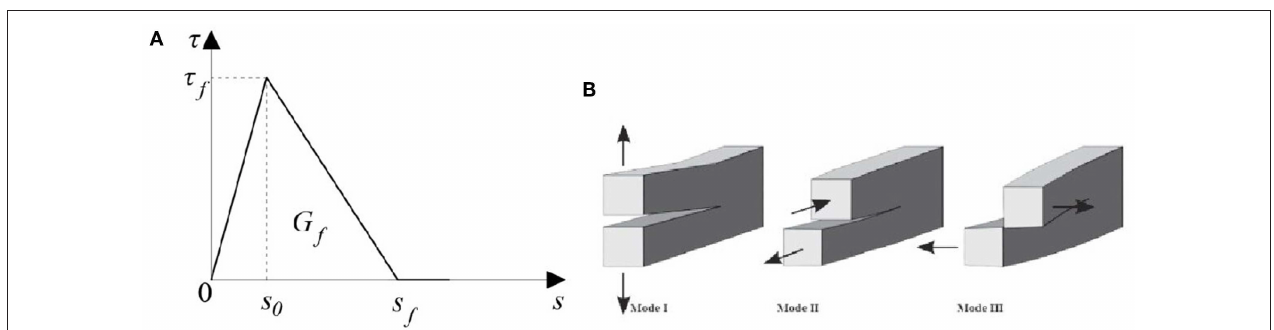
Frontiers in Built Environment |